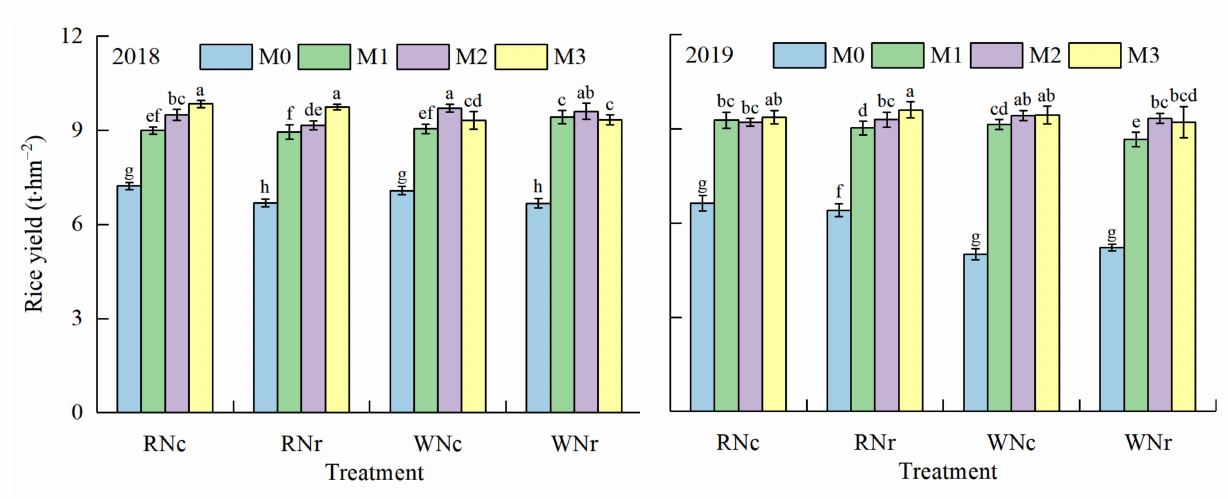
Figure 2. The effects of the N application rate in the previous season and N management in the rice season on the rice yield. RNc and RNr represent the conventional nitrogen application and reduced nitrogen application in the rape season, respectively. WNc and WNr represent the conventional nitrogen application and reduced nitrogen application in the wheat season, respectively. M0 represents zero N was used in rice season; M1, M2, and M3 represent based on an application rate of 150 kg/hm 2 N in the rice season, three N management models were applied, in which the application ratio of base:tiller:panicle fertilizer was 20%:20%:60%, 30%:30%:40%, and 40%:40%:20%, respectively. Lower case letters indicate that the yields of the hybrid rice are significantly different among the treatments ( p < 0.05, LSD